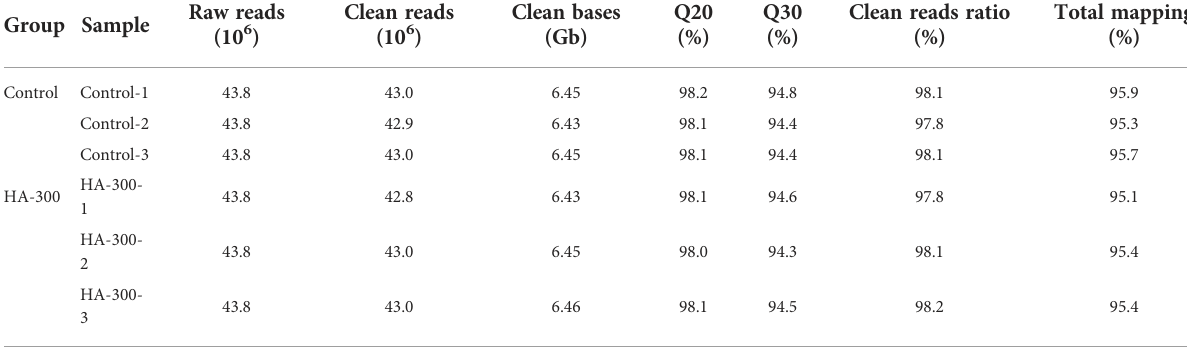
TABLE 4 Summary of transcriptome sequencing and mapping for largemouth